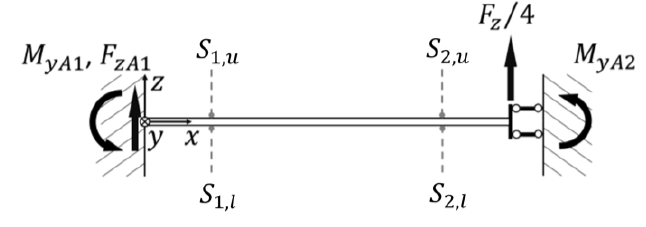
Figure 5. Load Condition A for beam-1 with force applied in the z- direction.